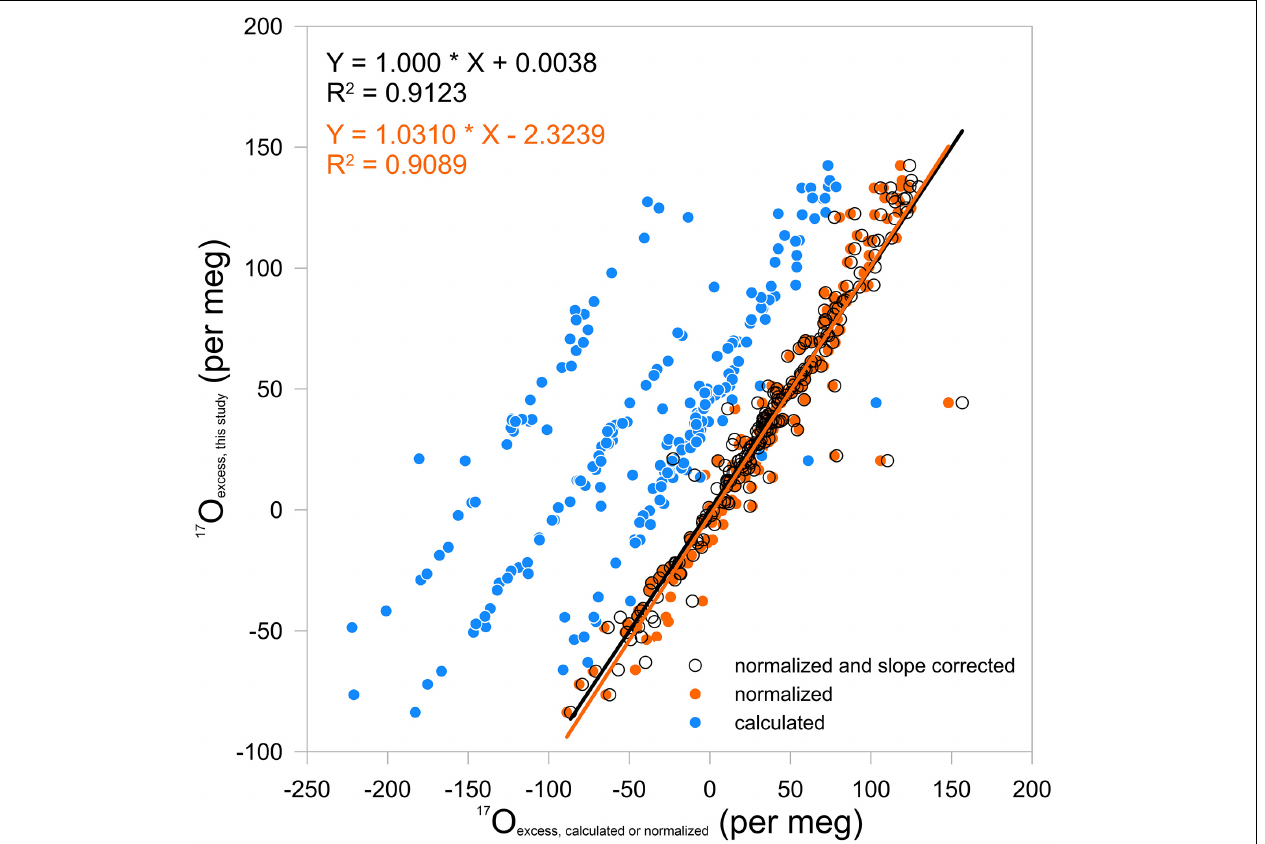
FIGURE 4 | Calculated 17 O excess based on calibrated δ 17 O and δ 18 O (blue) values and versus measured 17 O excess . Values of 17 O excess calibrated from this study (see Figure 1 ; y -axis) are compared with the calculated values based on measured δ 17 O and δ 18 O that were themselves calibrated with different standards (blue dots; x -axis) and with normalized values such that zero offsets are eliminated (open black dots; x -axis) or slope and offset corrected (orange dots; x -axis). Here, the blue dots document the long-term variability of 17 O excess measurements of the laser spectrometer. See our protocol in Supplementary Figure 1